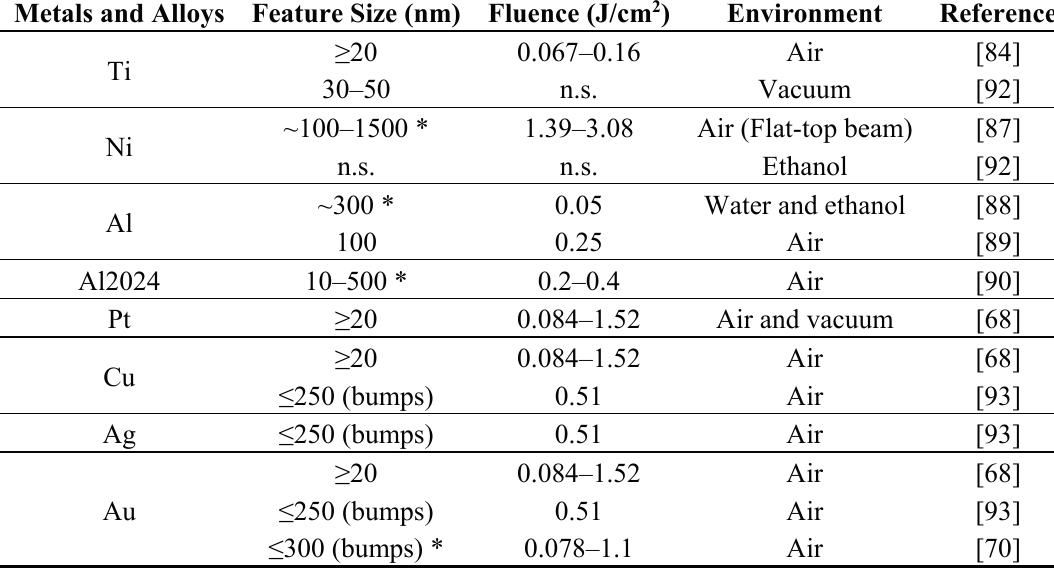
Table 2. Random nanostructures on different metals and alloys with their size, fluence used to produce the features and environment of micromachining. * Values are estimated from the SEM images. n.s. = not